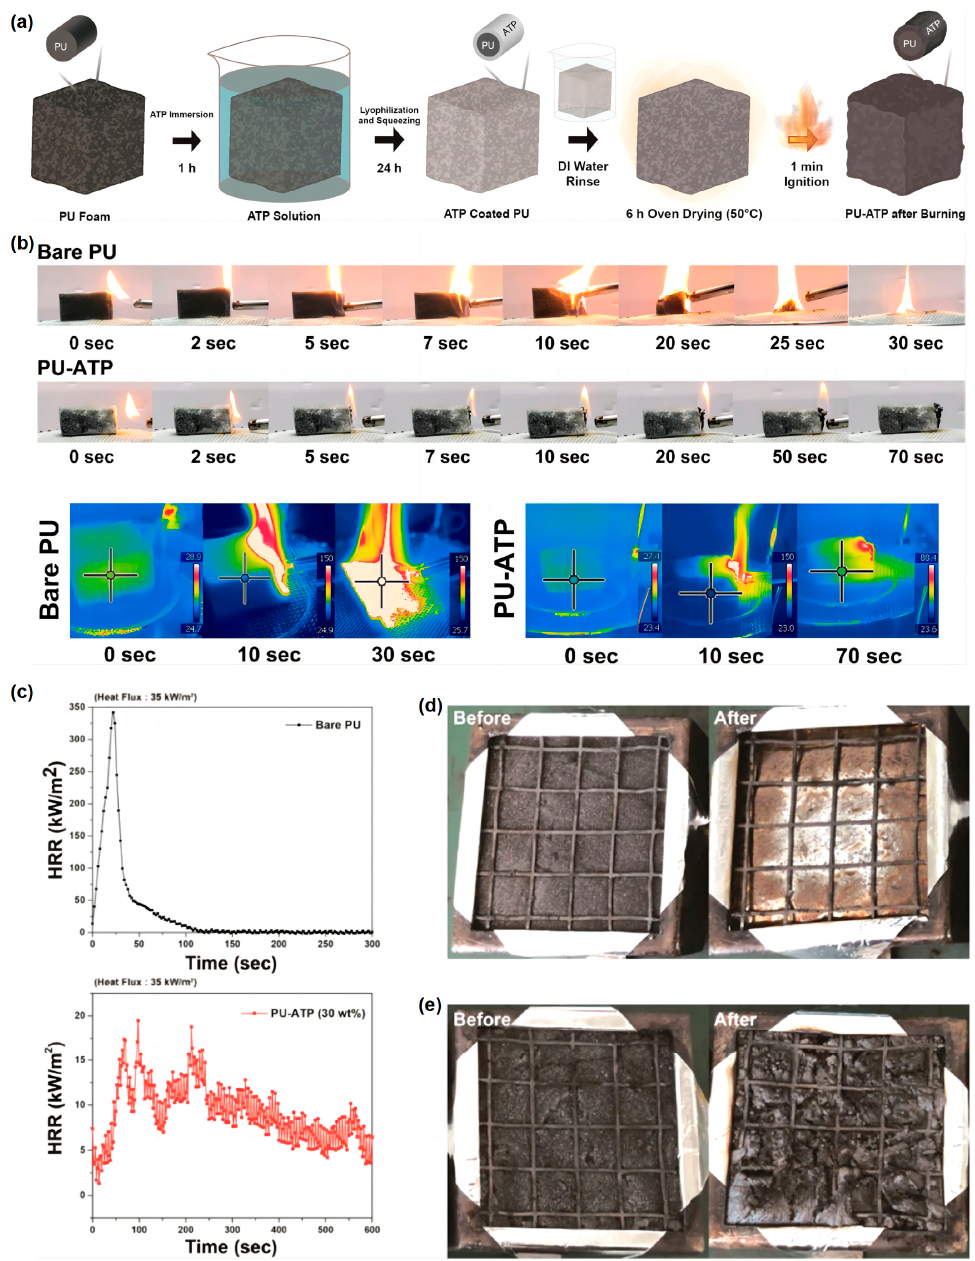
Figure 12. ( a ) The schematic diagram of the manufacturing process of PU-ATP. ( b ) Digital images of pure PU and PU-ATP (with 30% load) during the direct burning test. ( c ) HRR of pure PU and PU-ATP (with 30% load). Digital images before and after the cone test of ( d ) pure PU and ( e ) PU-ATP (with 30% load) [67].